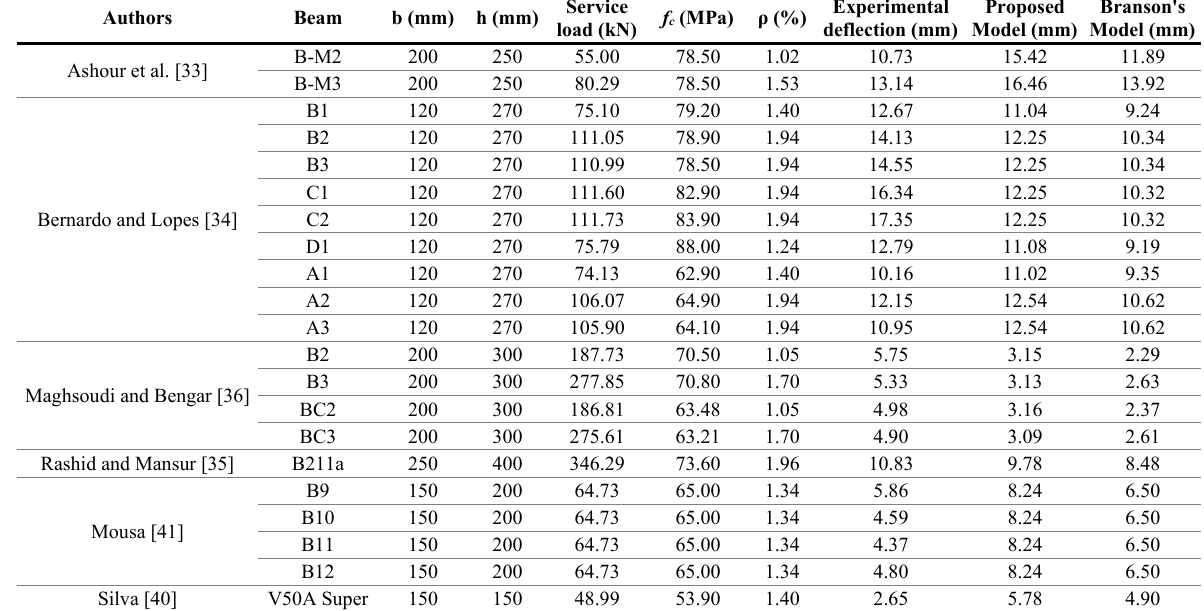
Table A4. Beams data with f c from 50MPa to 90MPa and reinforcement rate from 1% to 2%. Authors